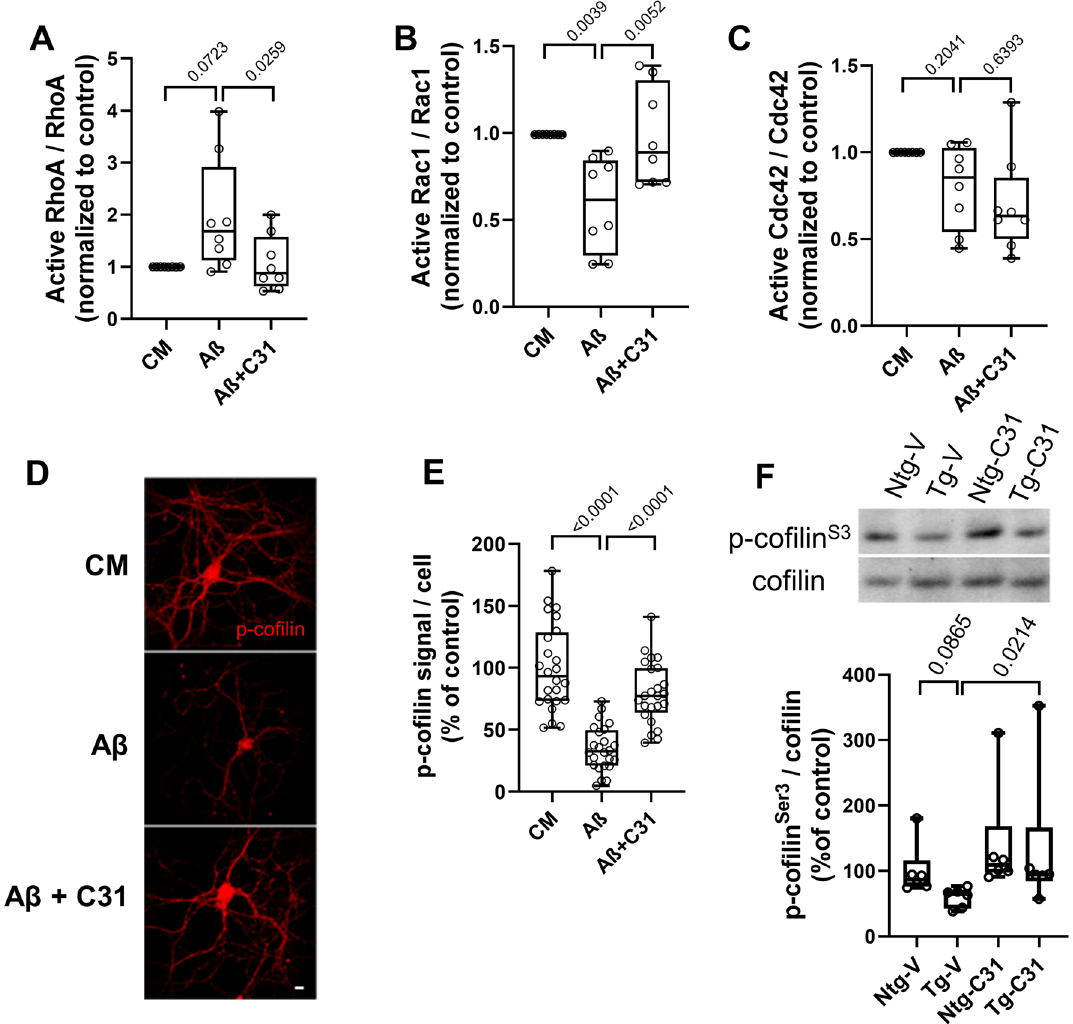
Figure 5. Aβ-induced changes in cofilin and Rho-family signaling are normalized by LM11A-31. ( A – E ) 21 DIV hippocampal neurons were treated with CM or Aβ ± LM11A-31 and cells were harvested after one hour for cell extract preparation. ( A – C ) For each assay measuring RhoA, Rac1 or Cdc42 GTPase, n = 9 protein preparations from independent experiments were measured, each protein preparation was tested using each of the three assays in duplicate and the two values were averaged. ( D ) Representative immunostaining images for p-cofilin Ser3 . Scale bar, 10 µm. ( E ) For p-cofilin S3 quantitation, total fluorescence intensity over total cell number per field was calculated, n = 24 fields derived from a total of 4 independent experiments. Statistical significance was determined for the indicated comparisons using Kruskal–Wallis ANOVA with post-hoc Dunn’s Multiple Comparisons test. ( F ) 7.5–8.0-month-old non-transgenic mice (Ntg) and AβPPL/S mice (Tg) were treated with LM11A-31 by oral gavage for 3 months. RIPA protein extracts from hippocampal tissue were assessed by western blotting for the ratio of p-cofilin Ser3 to total cofilin signal. N = 6 mice per group, with the values from three independent western analyses averaged per animal. Statistical significance of the indicated comparisons was determined in ( A , B , C , F ) using Kruskal–Wallis ANOVA with post-hoc Dunn’s multiple comparisons test and in ( E ) using Regular ANOVA with post-hoc Sidak’s multiple comparison